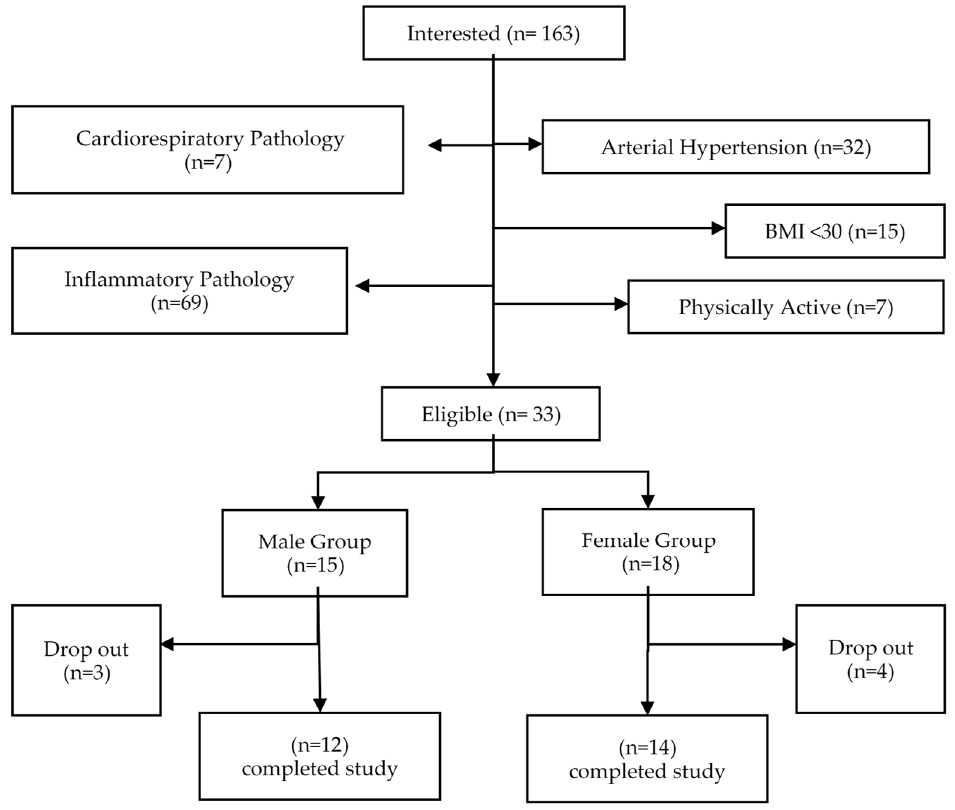
Figure 1. Recruitment flowchart.